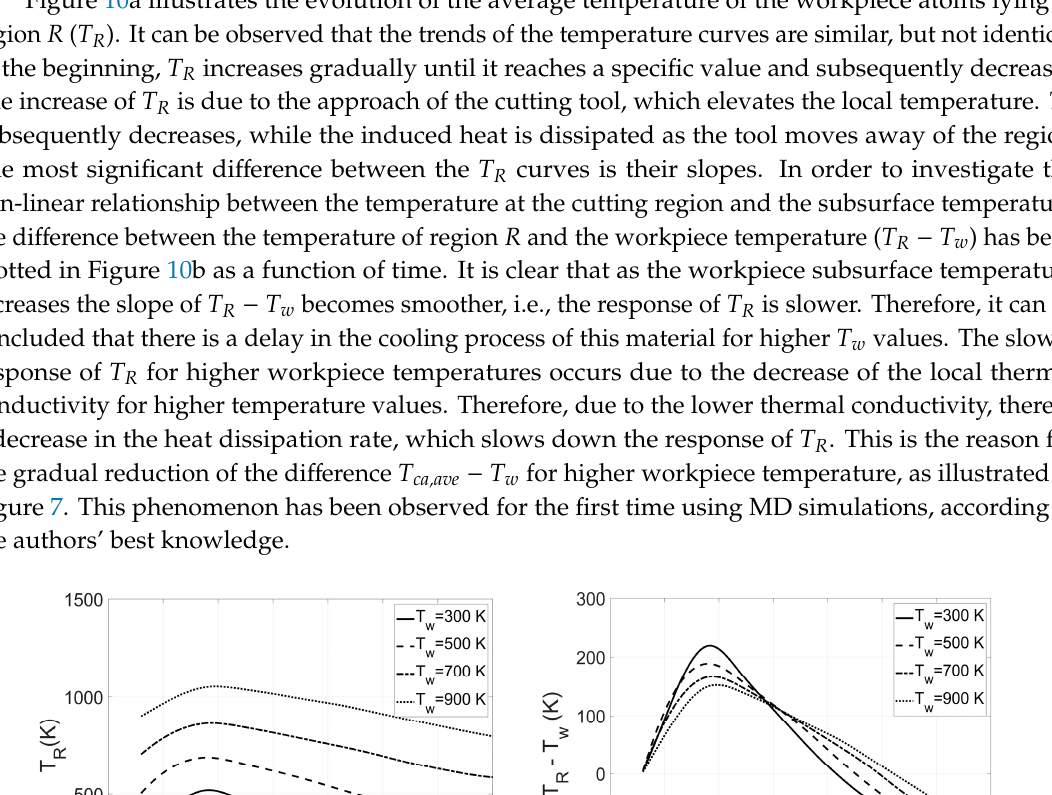
Figure 9. Location of region R.